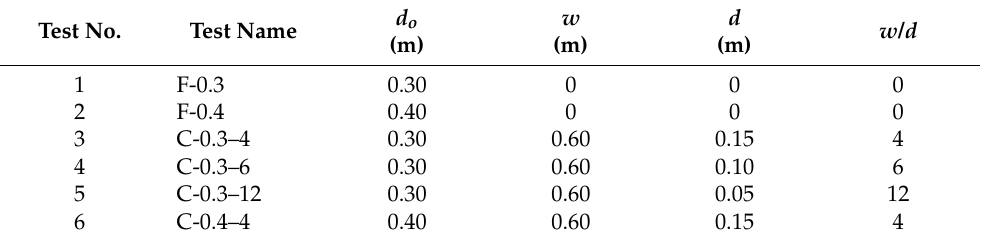
Table 1. Parameters of the performed